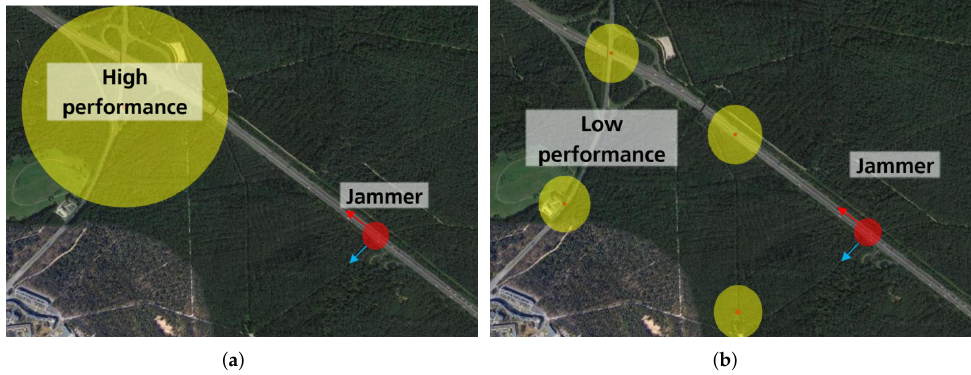
Figure 1. A qualitative example comparison of the symbolic coverage (yellow colored area) of a single high-performance monitoring receiver to a distributed network of low-performance receivers. In both cases, the POI is too low to detect the interference signal (red-colored interference